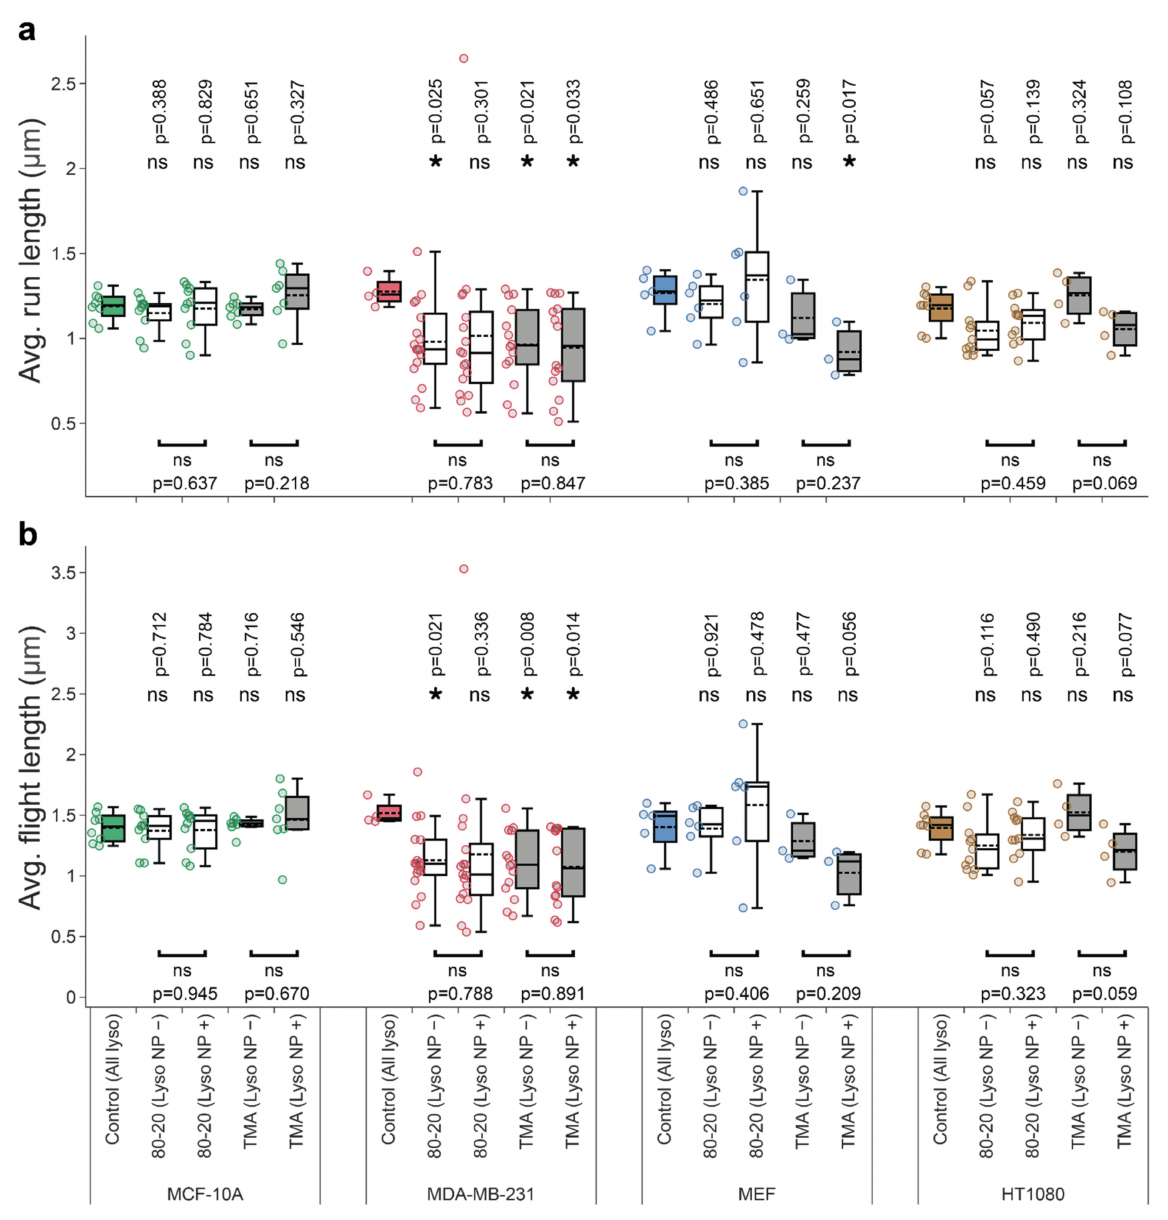
Figure A2. The effect of nanoparticle cargos on the average run ( a ) and flight ( b ) lengths. The notation of the box plots and experimental source data are identical to the main-text Figures 4 and 5. Asterisk or ‘ns’ indicated in the lower part of the plots indicate presence or absence of statistically significant differences, respectively, between parameters for lysosomes with or without cargos determined with two-tailed paired Student’s t test (* p < 0.05). Similarly, asterisk or ‘ns’ above the box plots indicate statistical significance of the difference between lysosomes from cells treated with NPs (white and grey boxes) versus all lysosomes in untreated, control cells (colored boxes) determined using Wilcoxon–Mann–Whitney test (* p < 0.05). The analyses were based on the following number of cells and lysosome trajectories: MCF-10A/Control ( n = 8 cells, l = 5260 lysosome trajectories); MCF-10A/80-20 ( n = 10): NP − ( l = 4177), NP+ ( l = 597); MCF-10A/TMA ( n = 12): NP − ( l = 3769), NP+ ( l = 303); MDA-MB-231/Control ( n = 4, l = 1076); MDA-MB-231/80-20 ( n = 17): NP − ( l = 2771), NP+ ( l = 260); MDA-MB-231/TMA ( n = 14): NP − ( l = 1618), NP+ ( l = 116); MEF/Control ( n = 5, l = 5781); MEF/80–20 ( n = 6): NP − ( l = 6272), NP+ ( l = 131); MEF/TMA ( n = 3): NP − ( l = 5304), NP+ ( l = 36); and HT-1080/Control ( n = 8, l = 7953); HT/80–20 ( n = 11): NP − ( l = 4294), NP+ ( l = 304); HT/TMA ( n = 4): NP − ( l = 2283), NP+ ( l =